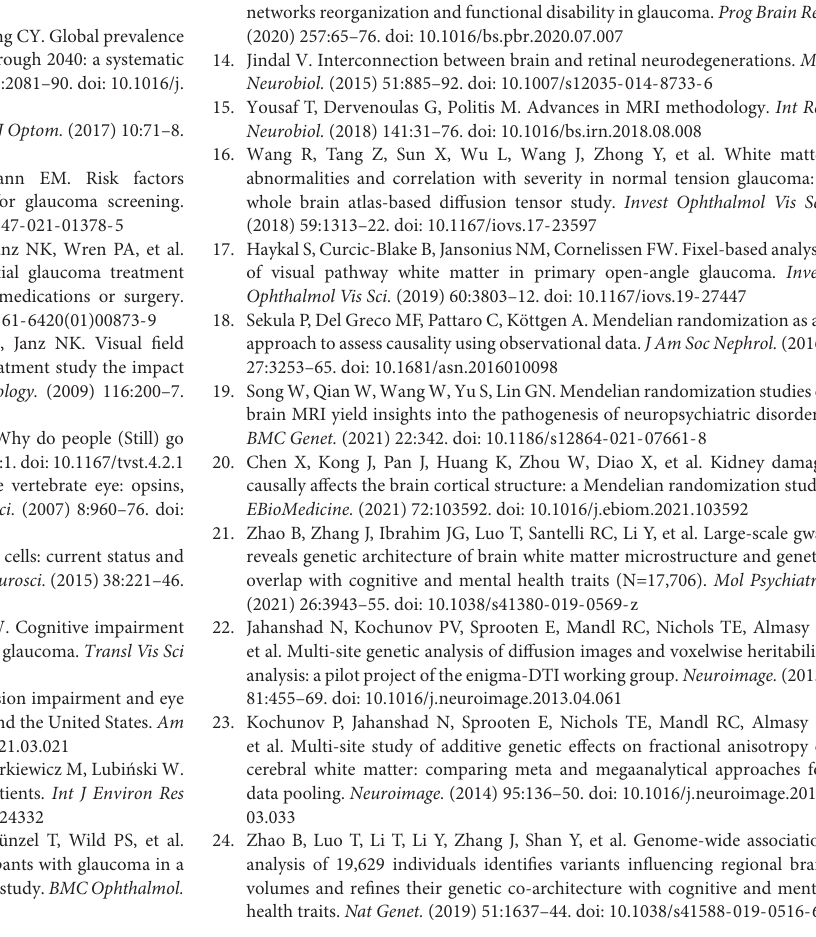
Supplementary Figure 1 | Leave-one-out permutation analysis for the fornix fractional anisotropy (A) , uncinate fasciculus fractional anisotropy (B) , and the volume of right ventral diencephalon (C) and brain stem (D)